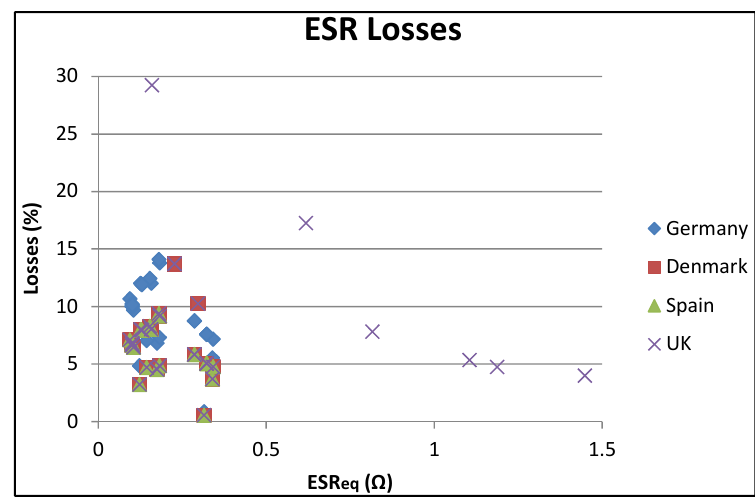
Figure A1. ESR losses in the German